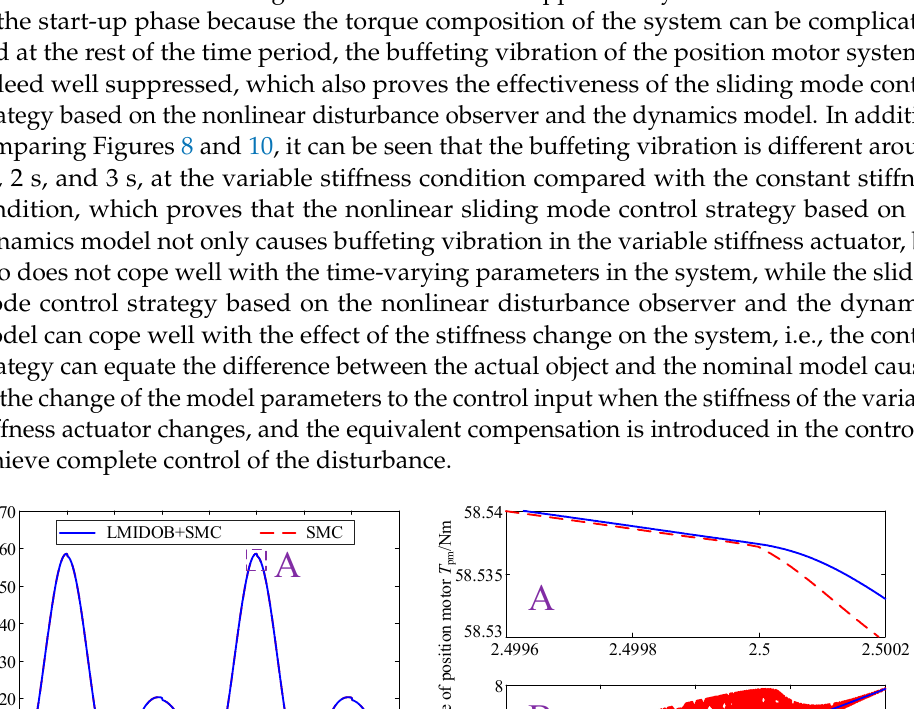
Figure 9. Position tracking performance of control strategy at the variable stiffness condition.